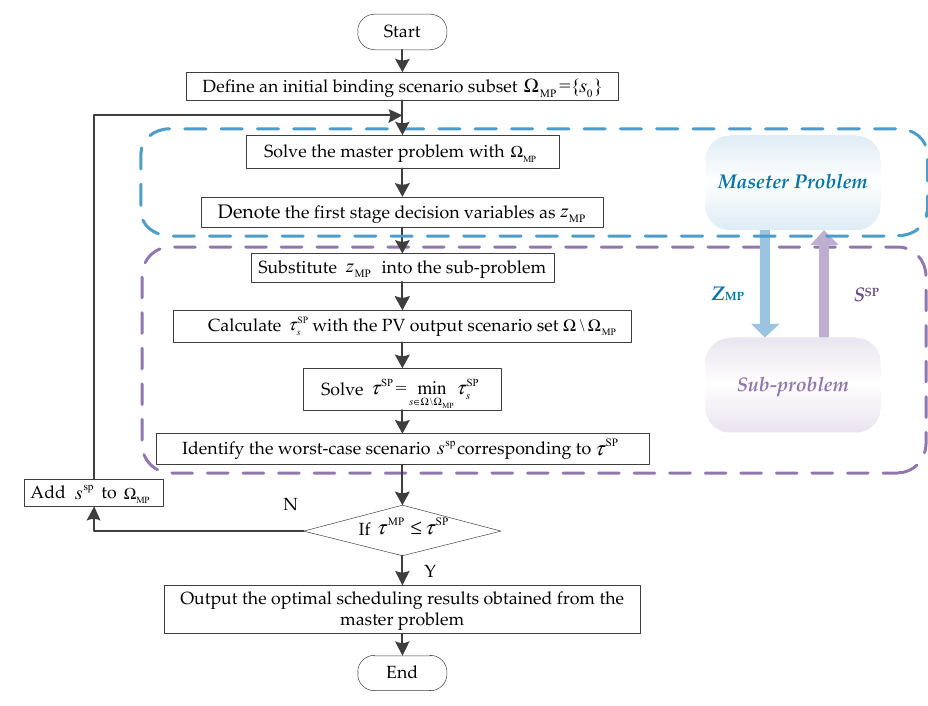
Figure 4. F lowchart of the binding scenario identification algorithm. Figure 4. Flowchart of the binding scenario identification